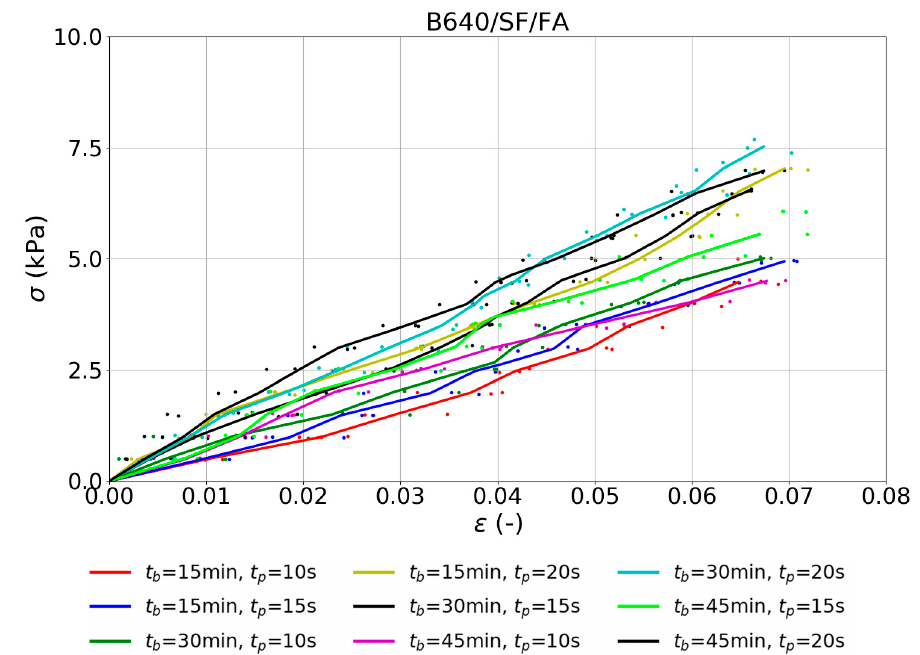
Figure 9. Stress–strain relations for mixes B640/SF/FA.